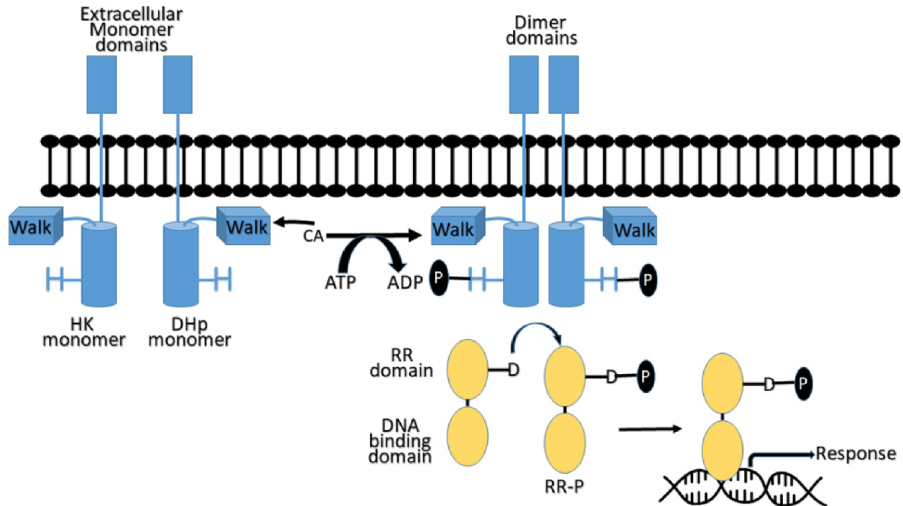
Fig 1. Two-Component Signaling (TCS) system pathway. HK (blue), histidine kinase; RR (beige), response regulator; H, conserved histidine residue; D, conserved aspartic acid residue.